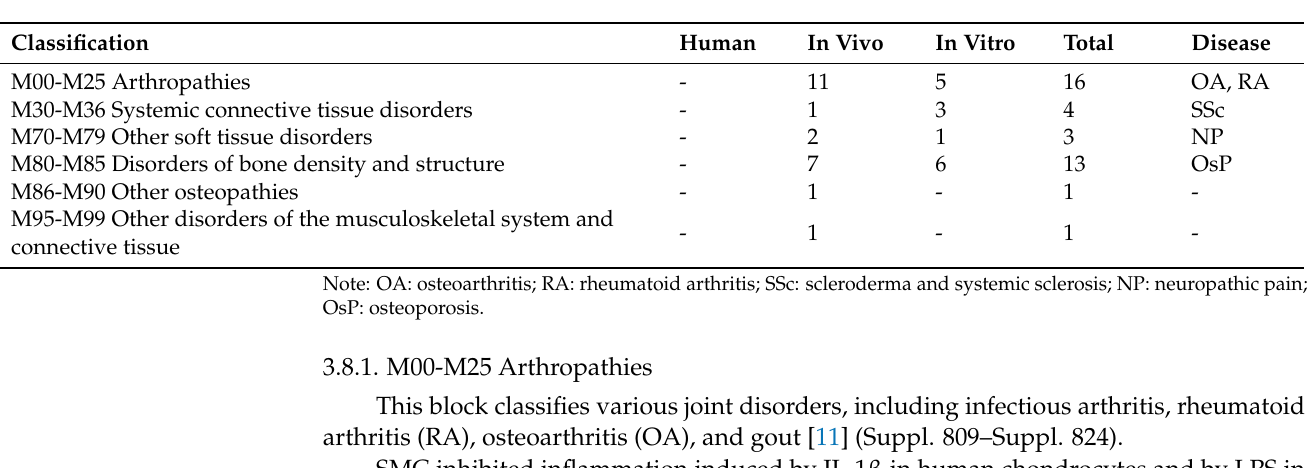
Table 10. The statistics of pharmacological results and its major diseases of SMC by experimental type in XIII Diseases of the musculoskeletal system and connective tissue of